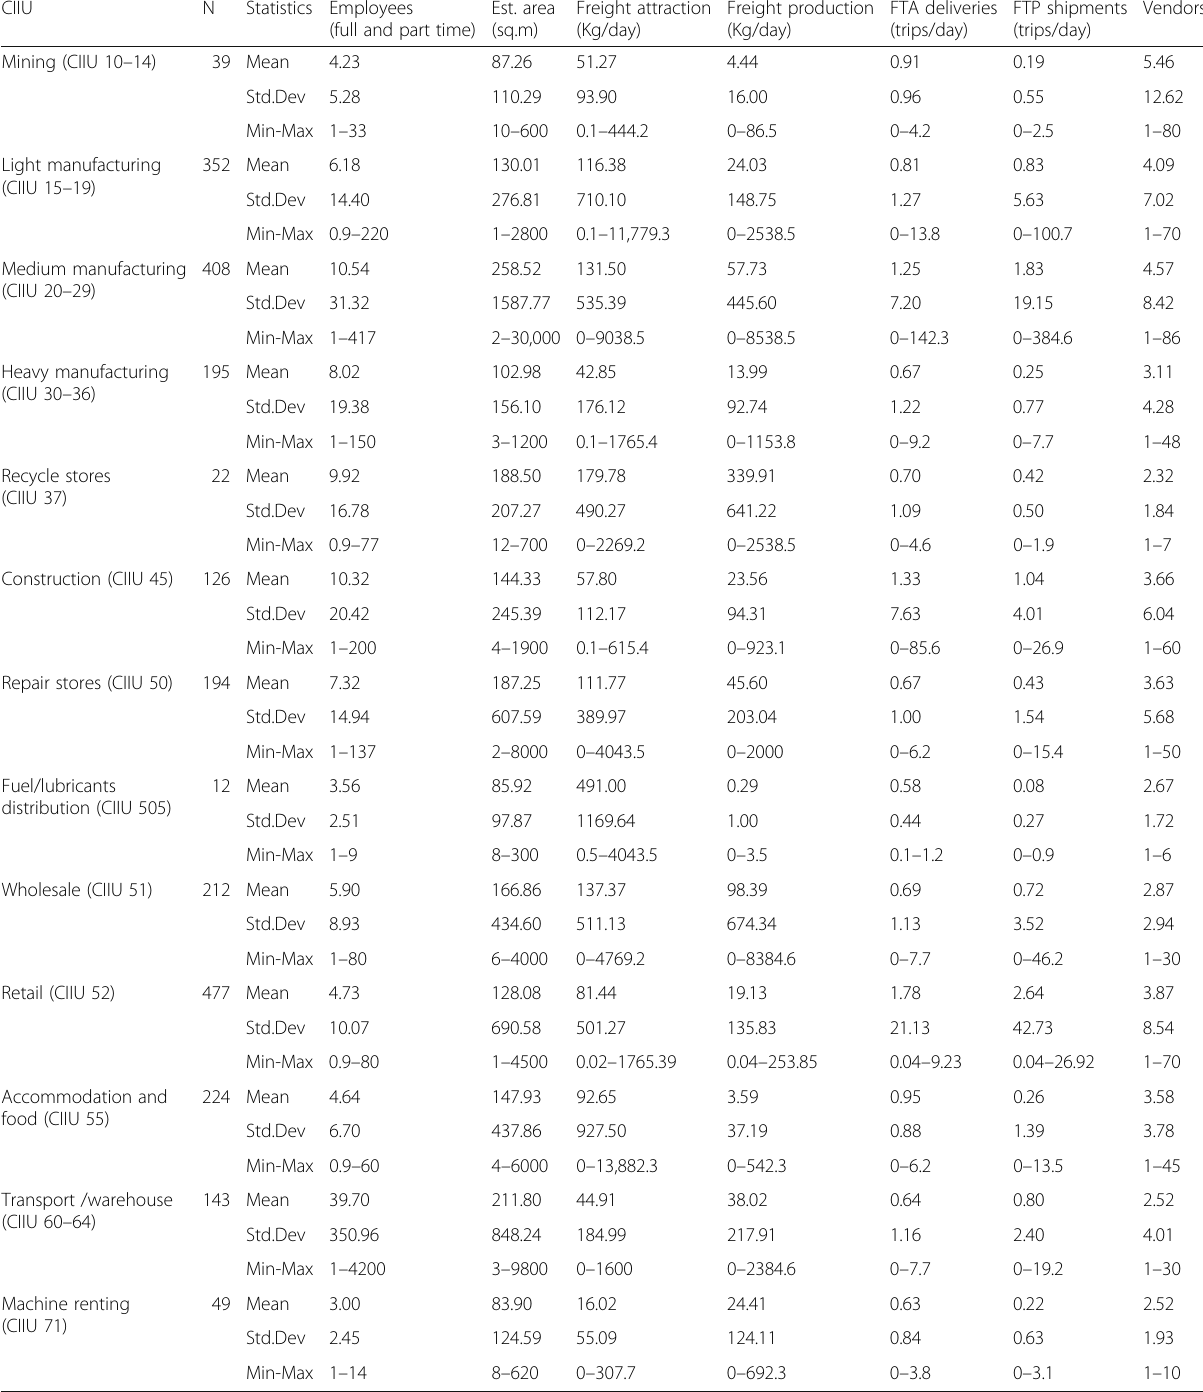
Table 5 Statistics of Freight Intensive Sector (FIS) commercial establishments CIIU N Statistics Employees